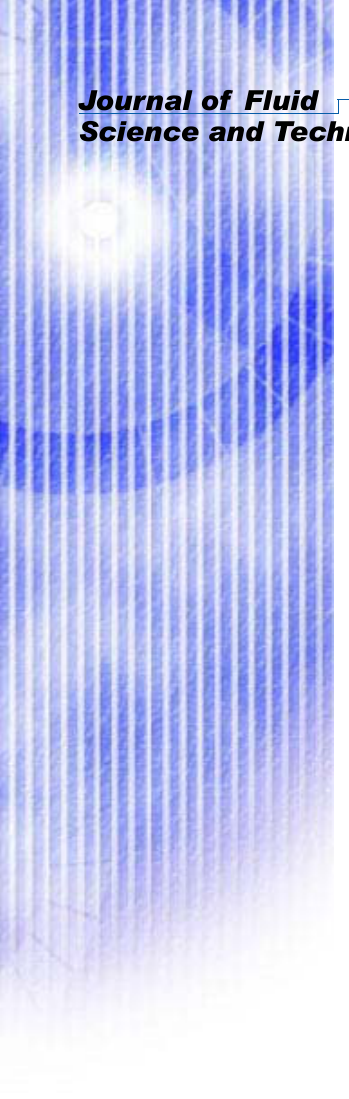
Fig. 7 Interface profiles at times when the wave crest and trough respectively reaches their maximum displacements.